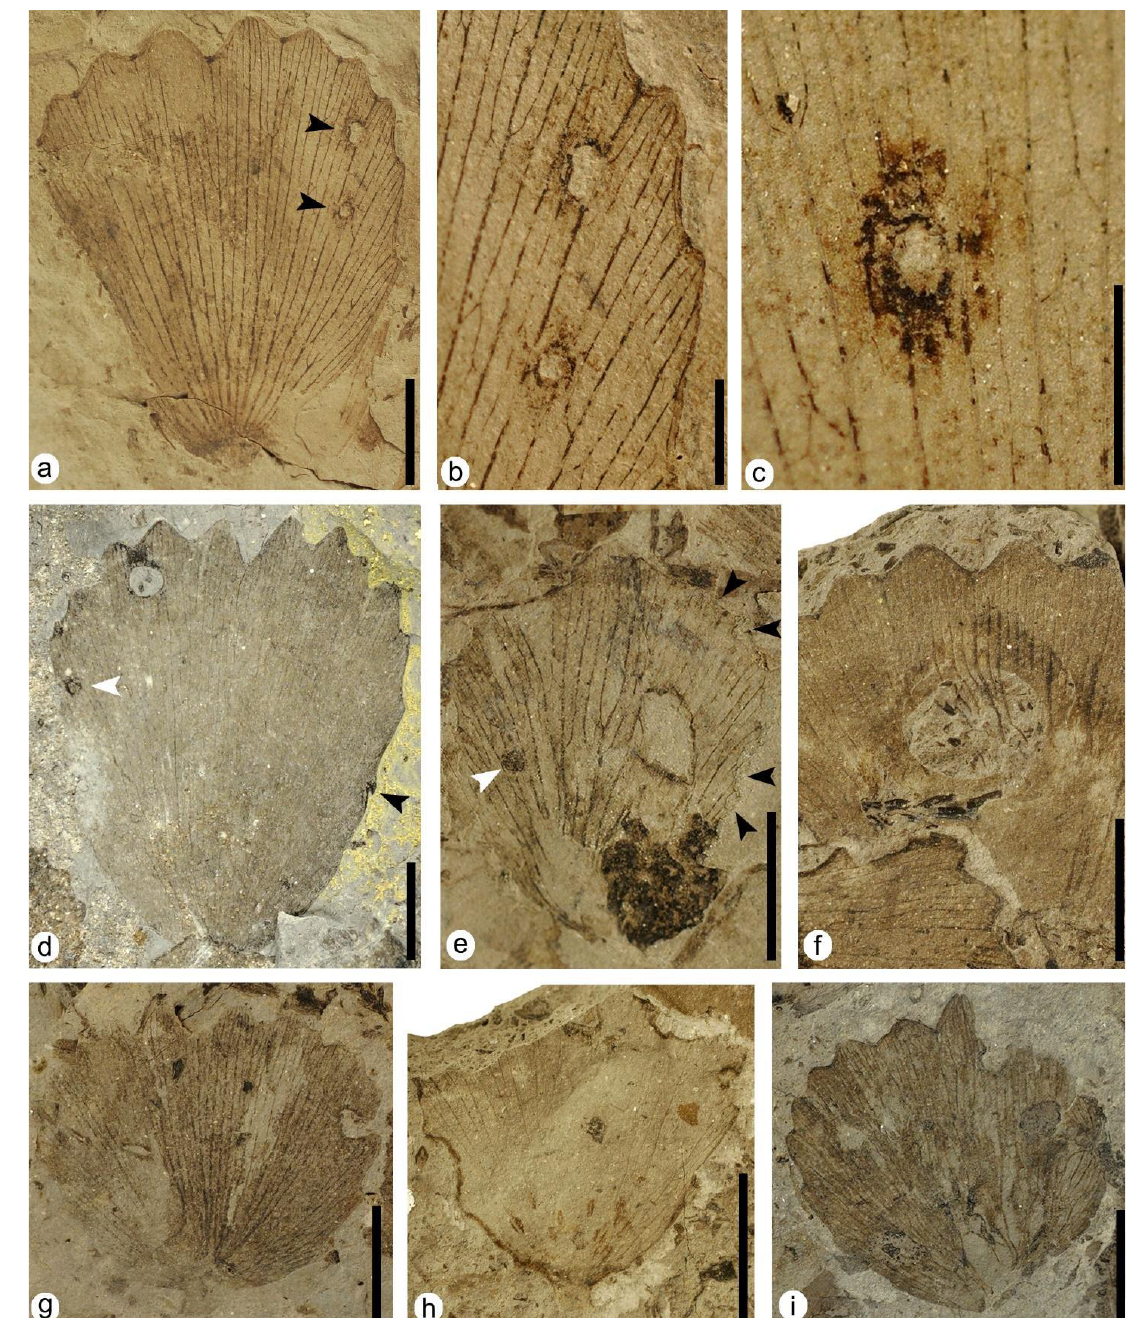
Figure 3. Plant – insect interactions on leaves of the aquatic angiosperm Klitzschophyllites . ( a ) MAP-8346, a complete leaf with hole feeding DT01 and DT02 indicated with black arrowheads. ( b ) Detail of the two holes DT01 and DT02 in photo ( a ). ( c ) Detail of the counterpart of the lower hole DT01 in photo (b) showing the thick reaction rim. ( d ) MAP-8347, a complete big leaf with hole feeding DT02, margin feeding DT12 (black arrowhead), and mining DT66 (white arrowhead). ( e ) MAP-8349, a nearly complete leaf with hole feeding DT03, margin feeding DT81 (black arrowheads) and galling DT52 (white arrowhead). ( f ) MAP-8353, with a big hole feeding DT04 showing strings of veins. ( g ) MAP-8355, with hole feeding DT07 and skeletonization DT16. ( h ) MAP-8354, with margin feeding DT12 and oviposition DT100. ( i ) MAP-8348, with hole feeding DT02 and margin feeding DT13 and DT26. Scale bars: a , d, f to i = 1 cm; b , c = 2 mm; e = 5 mm.